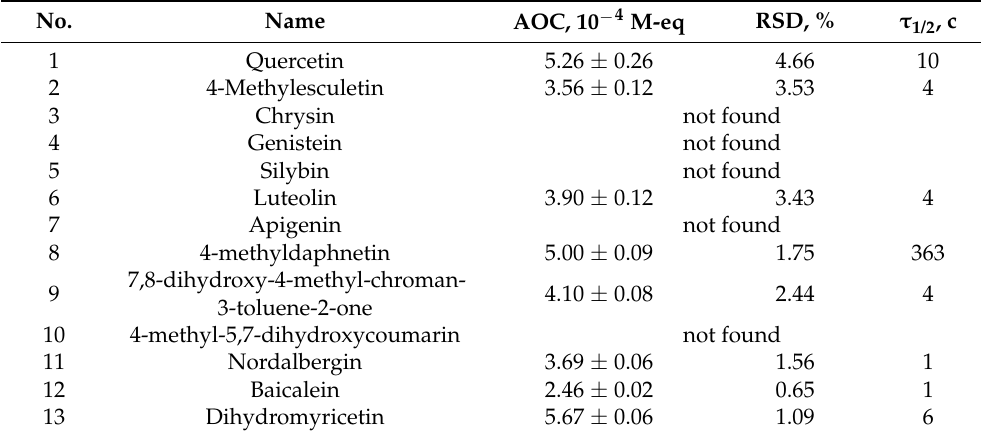
Table 3. AOC and half-reaction periods of studied antioxidants (C AO = 10 − 4 M, n = 5, p = 0.95).